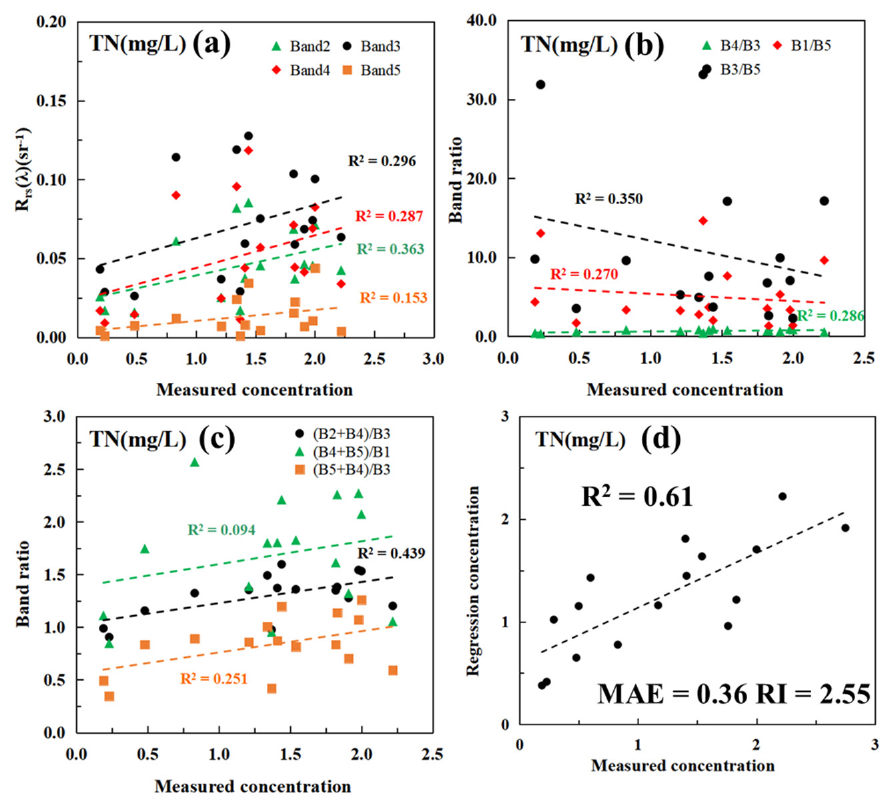
Figure 4. The results of the selected characteristic bands and statistical model validation. The correlation between ( a ) four single bands, ( b ) two band ratios, and ( c ) three band ratios and the measured concentration of TN. ( d ) the correlation coefficients of regression function (5) in Table 2.